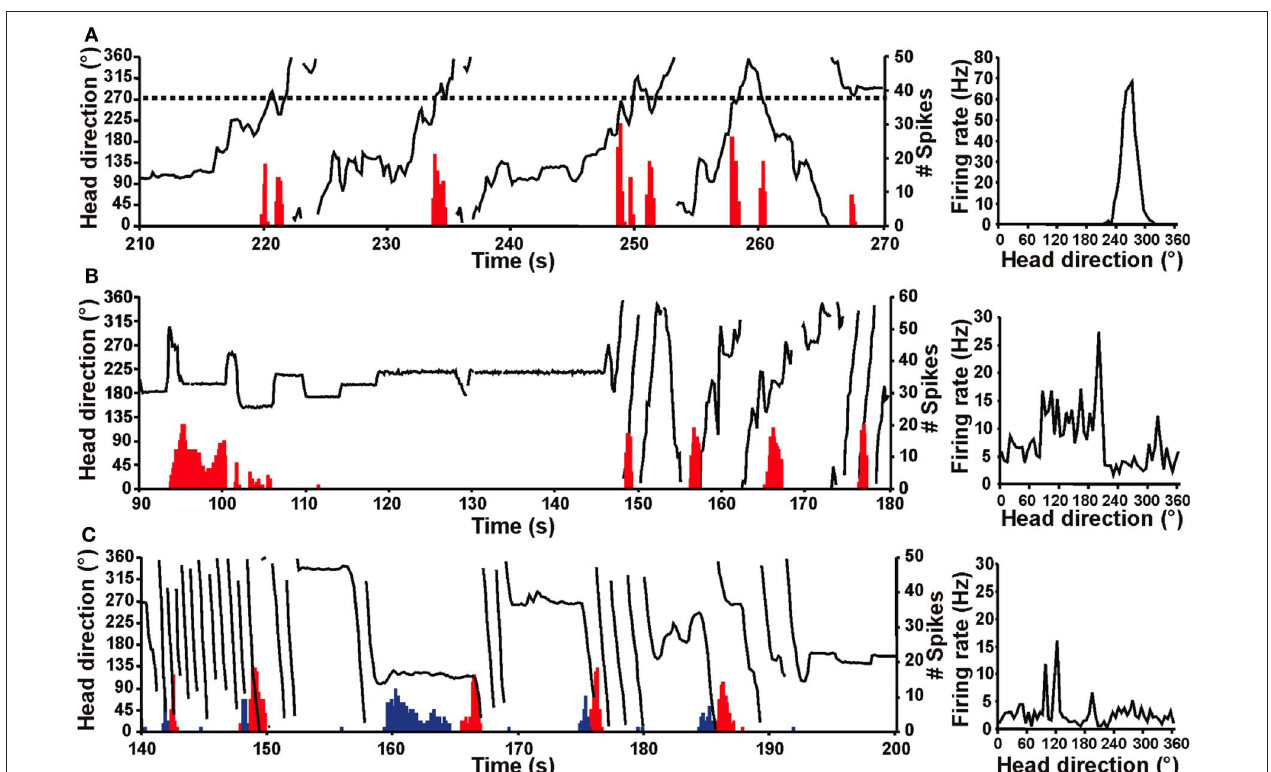
FIGURE 5 | Firing of normal HD and bursty cells over time (red histogram) relative to the chinchilla’s HD (black line) for portions of an 8min recording session in a high-walled gray cylinder (left panels). Corresponding firing rate × HD plots (right panels) for the cell shown at the left. (A) HD cell from a control chinchilla. The dotted line (left panel) represents the cell’s preferred firing direction at ∼ 270 ◦ and this cell consistently fired at a high rate whenever the animal’s head pointed at 270 ◦ (i.e., when the dotted line intersects the HD plot). The firing rate × HD plot for the control chinchilla (right panel) shows a clear, single-peaked function at ∼ 270 ◦ that matches the preferred firing direction in the plot at left. (B,C) Bursty cells from canal-plugged chinchillas. Note that the bursty cell in